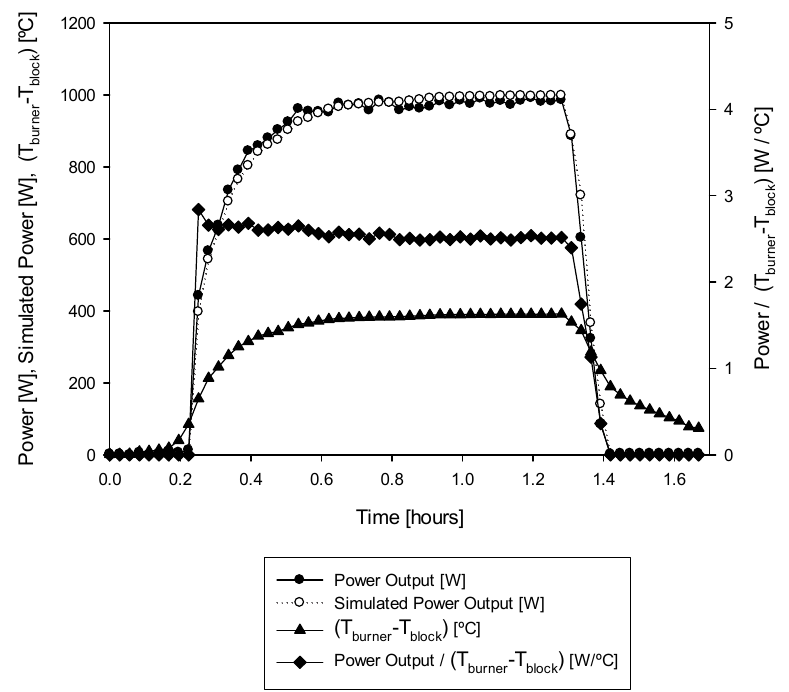
Figure 5. Simulated and experimental power